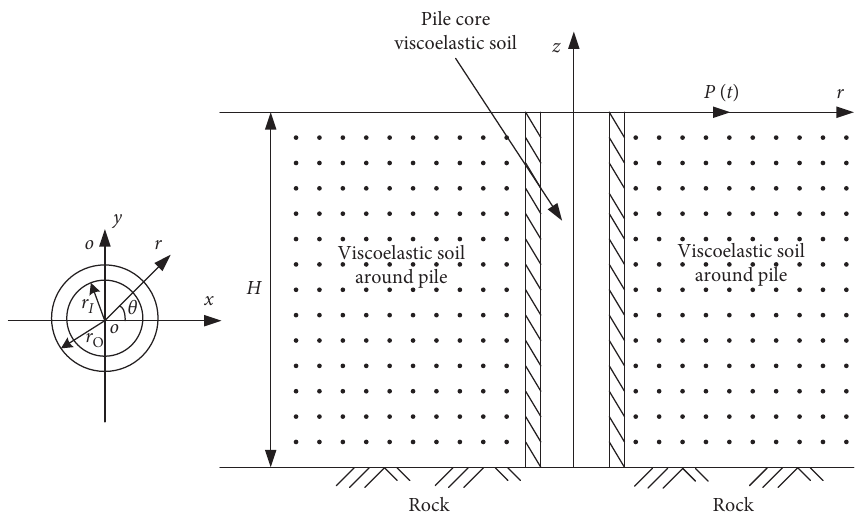
Figure 1: The model of soil layers and pipe